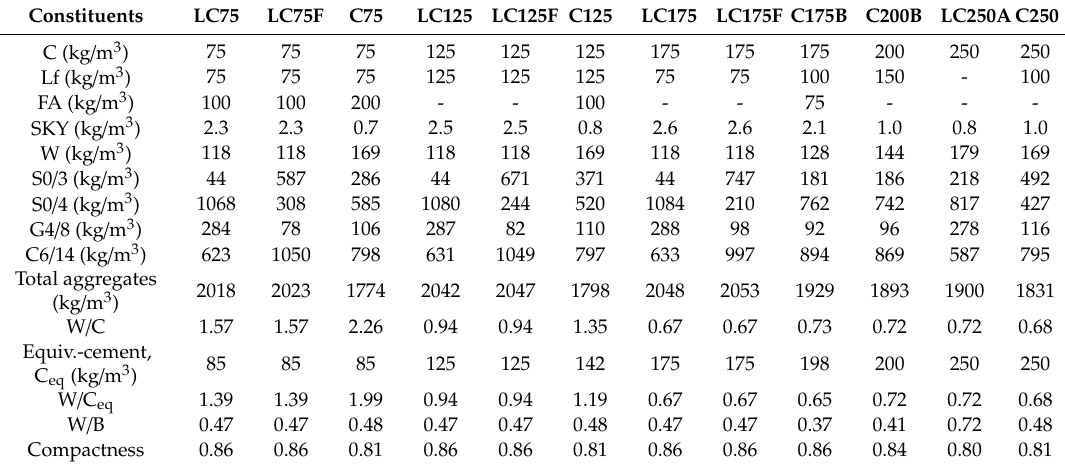
Table 1. Dosages of constituents and formulation parameters of the studied